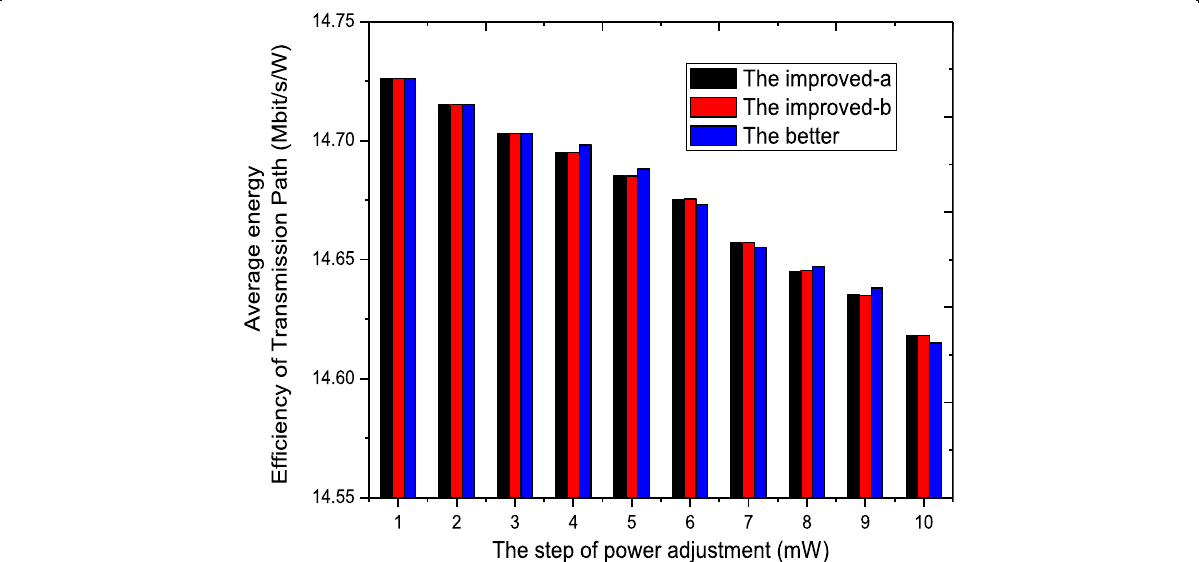
Fig. 17 Comparison of energy efficiency: variation trend of energy efficiency of TOM-PAOD with the step size for power adjustment, in which the different game decision algorithms are adopted respectively